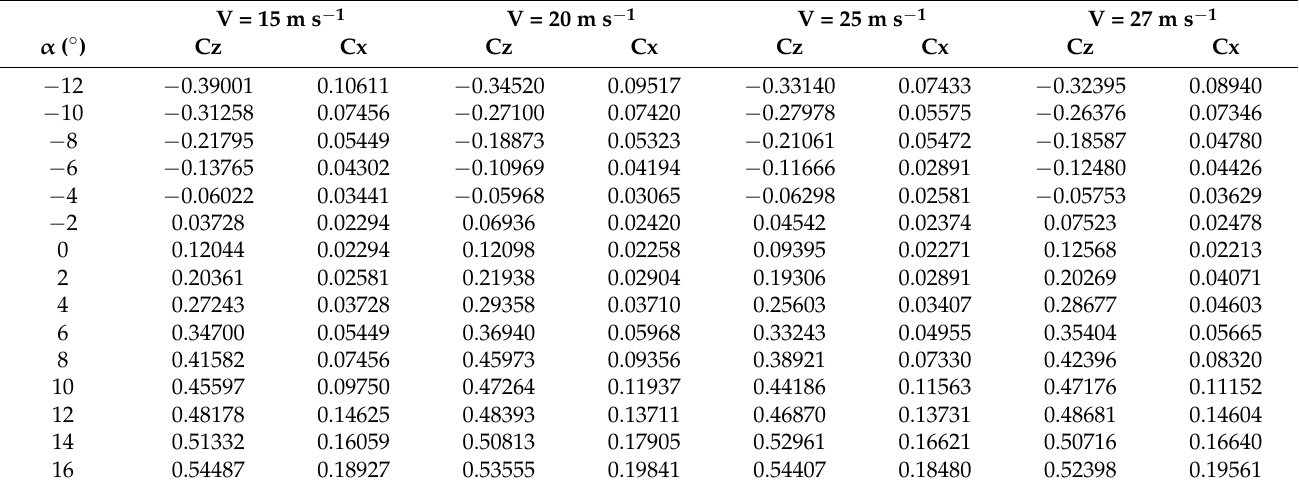
Table 4. Computed values of lift force coefficient, Cz, and drag force coefficient, Cx, for positive and negative angles of attack, α , for considered airflow velocities.